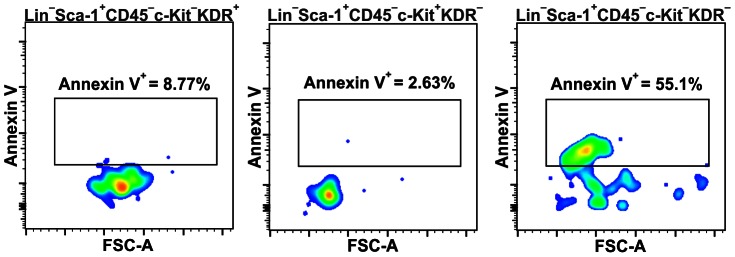
Binding of annexin V on Lin−Sca-1+CD45− subpopulations.Presence of annexin V on surface of cells from Lin−Sca-1+CD45− subpopulations was evaluated by flow cytometry. Majority of Lin−Sca-1+CD45−c-Kit−KDR+ and Lin−Sca-1+CD45−c-Kit+KDR− were annexin V negative, while more than half of the Lin−Sca-1+CD45−c-Kit−KDR− cells were annexin V positive.